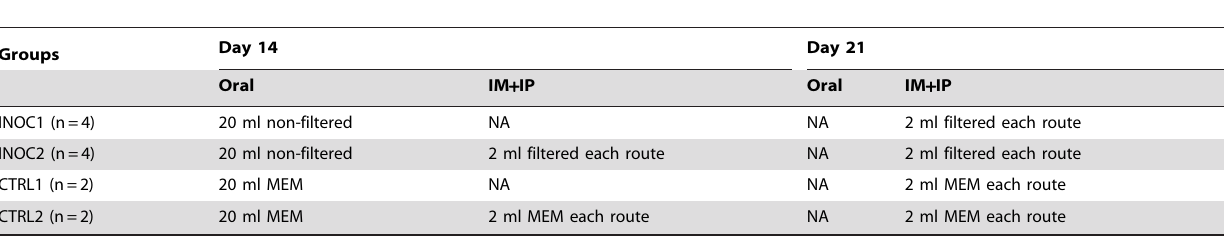
Table 1. Treatment groups and inoculation schedule for PFTS inoculation study.